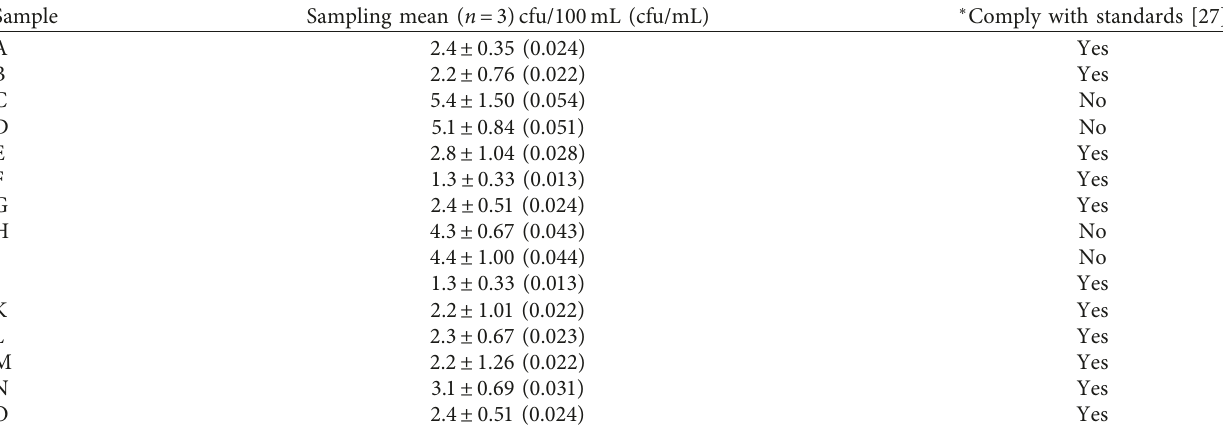
Table 3: The amount of coliforms for 15 samples of treated drinking water.